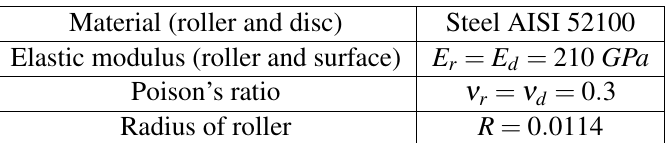
Table 1 Physical parameters of roller bearing.